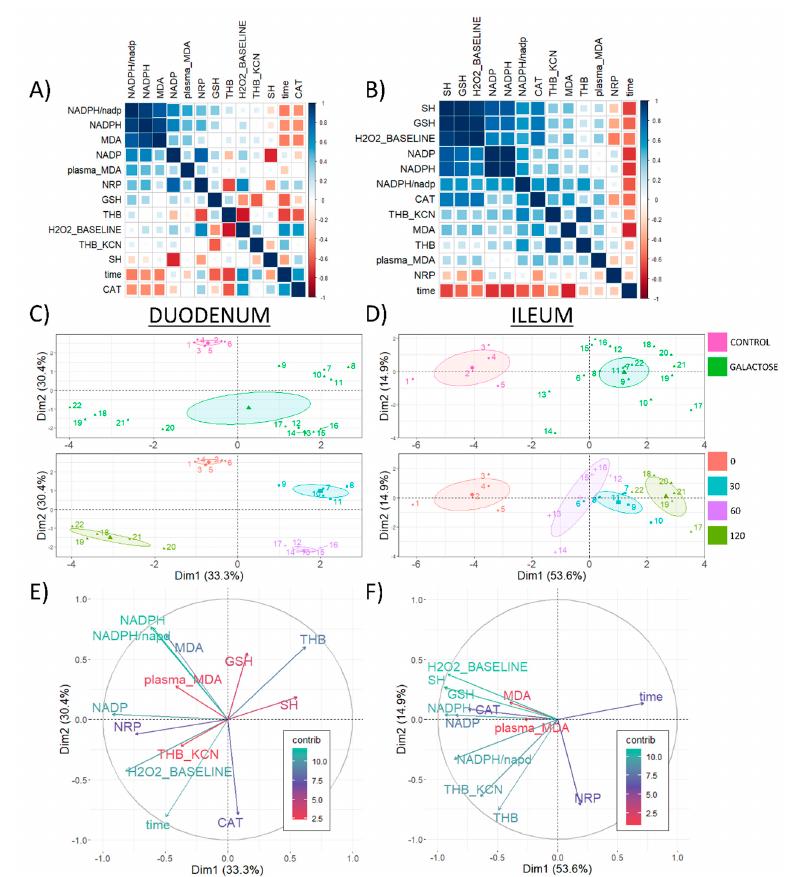
Figure 5. Correlation analysis of redox-related parameters in the rat duodenum and ileum following acute orogastric gavage of 200 mg/kg D -galactose. ( A ) Spearman’s rank correlation of duodenal redox-related parameters ordered by the first principal component. ( B ) Spearman’s rank correlation of ileal redox-related parameters ordered by the first principal component. ( C ) Duodenum principal component analysis biplot indicating coordinates of individual animals in respect to first and second principal components with colors indicating treatment (upper: baseline control vs. galactose treat- ment) and time since the exposure to orogastric gavage of 200 mg/kg D -galactose solution (lower: baseline control [0] vs. 30 [30] vs. 60 [60] vs. 120 [120] minutes since the exposure). ( D ) Ileum prin- cipal component analysis biplot indicating coordinates of individual animals in respect to first and second principal components with colors indicating treatment (upper: baseline control vs. galactose treatment) and time since the exposure to orogastric gavage of 200 mg/kg D -galactose solution (lower: baseline control [0] vs. 30 [30] vs. 60 [60] vs. 120 [120] minutes since the exposure). ( E ) Duodenum biplot graph of variables’ contributions to the 1st principal component (color and vector projection length) and the 2nd principal component (vector projection length). ( F ) Ileum biplot graph of variables’ contributions to the 1st principal component (color and vector projection length) and the 2nd principal component (vector projection length). NRP—nitrocellulose redox permanganometry; time—minutes since the exposure to treatment (continuous variable); THB_KCN—change in